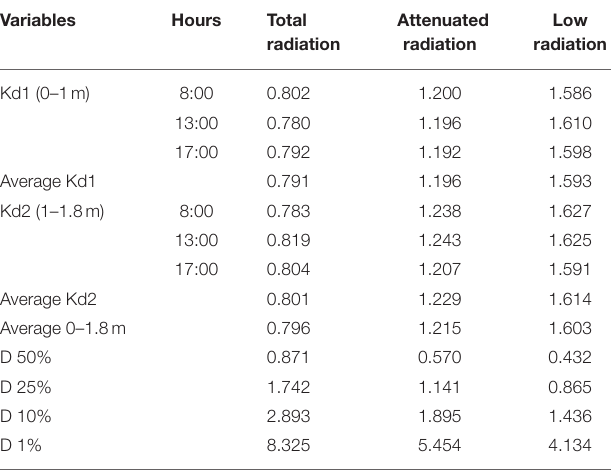
TABLE 1 | Kd data in the three different treatments: total, attenuated, and low radiation, for the mesocosm system, and the surface radiation to the different depths at 50, 15, 10, and